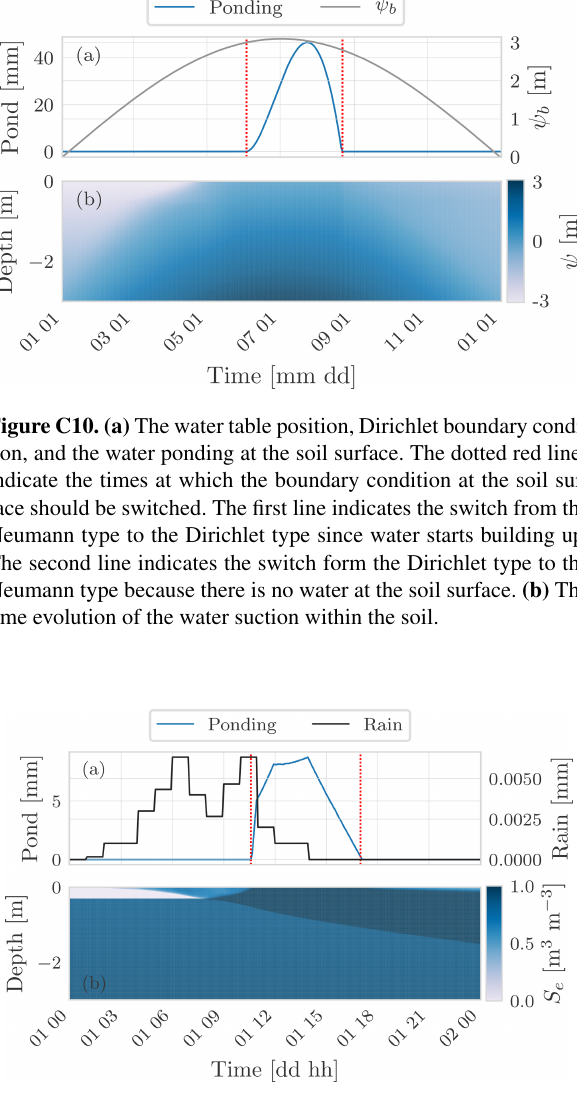
Figure C11. (a) The rainfall and the water ponding at the soil sur- face. Initially rainfall can infiltrate into the soil and no water builds up at the soil surface. As the uppermost layer of the soil saturates water starts ponding at the soil surface. The dotted red lines indicate the times at which the boundary condition at the soil surface should be switched. (b) The time evolution of the saturation degree within the